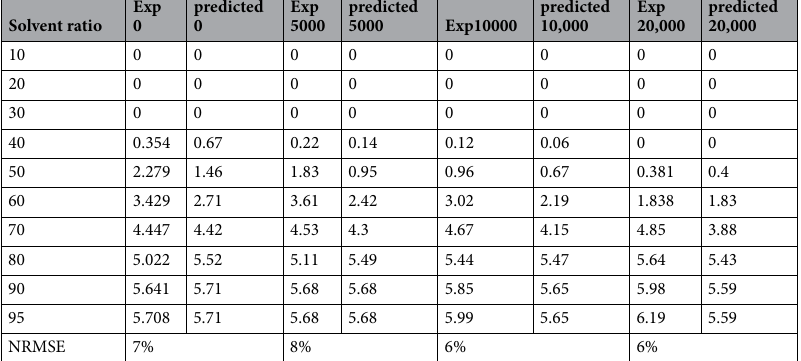
Table 8. Comparison of experimental and predicted asphaltene precipitation—Crude oil sample D (NRMSE = 6.7%).